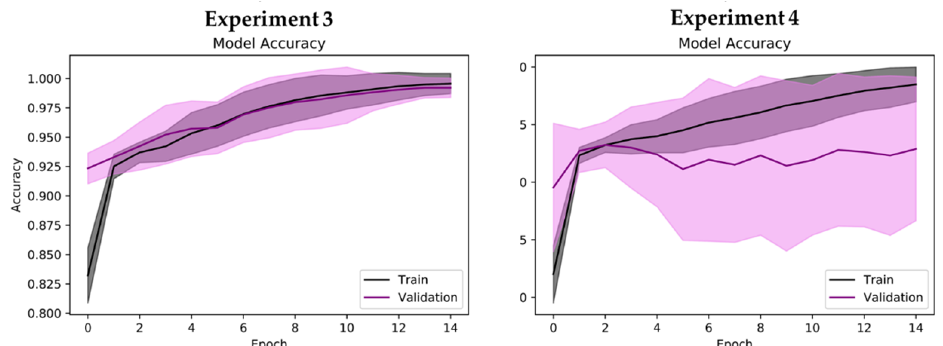
Figure 7. Performance graph (model accuracy) of proposed 2D-CNN model during tenfold cross- validation. Shaded region represents standard deviation of model accuracy during tenfold cross- validation (mean accuracy ± standard deviation).